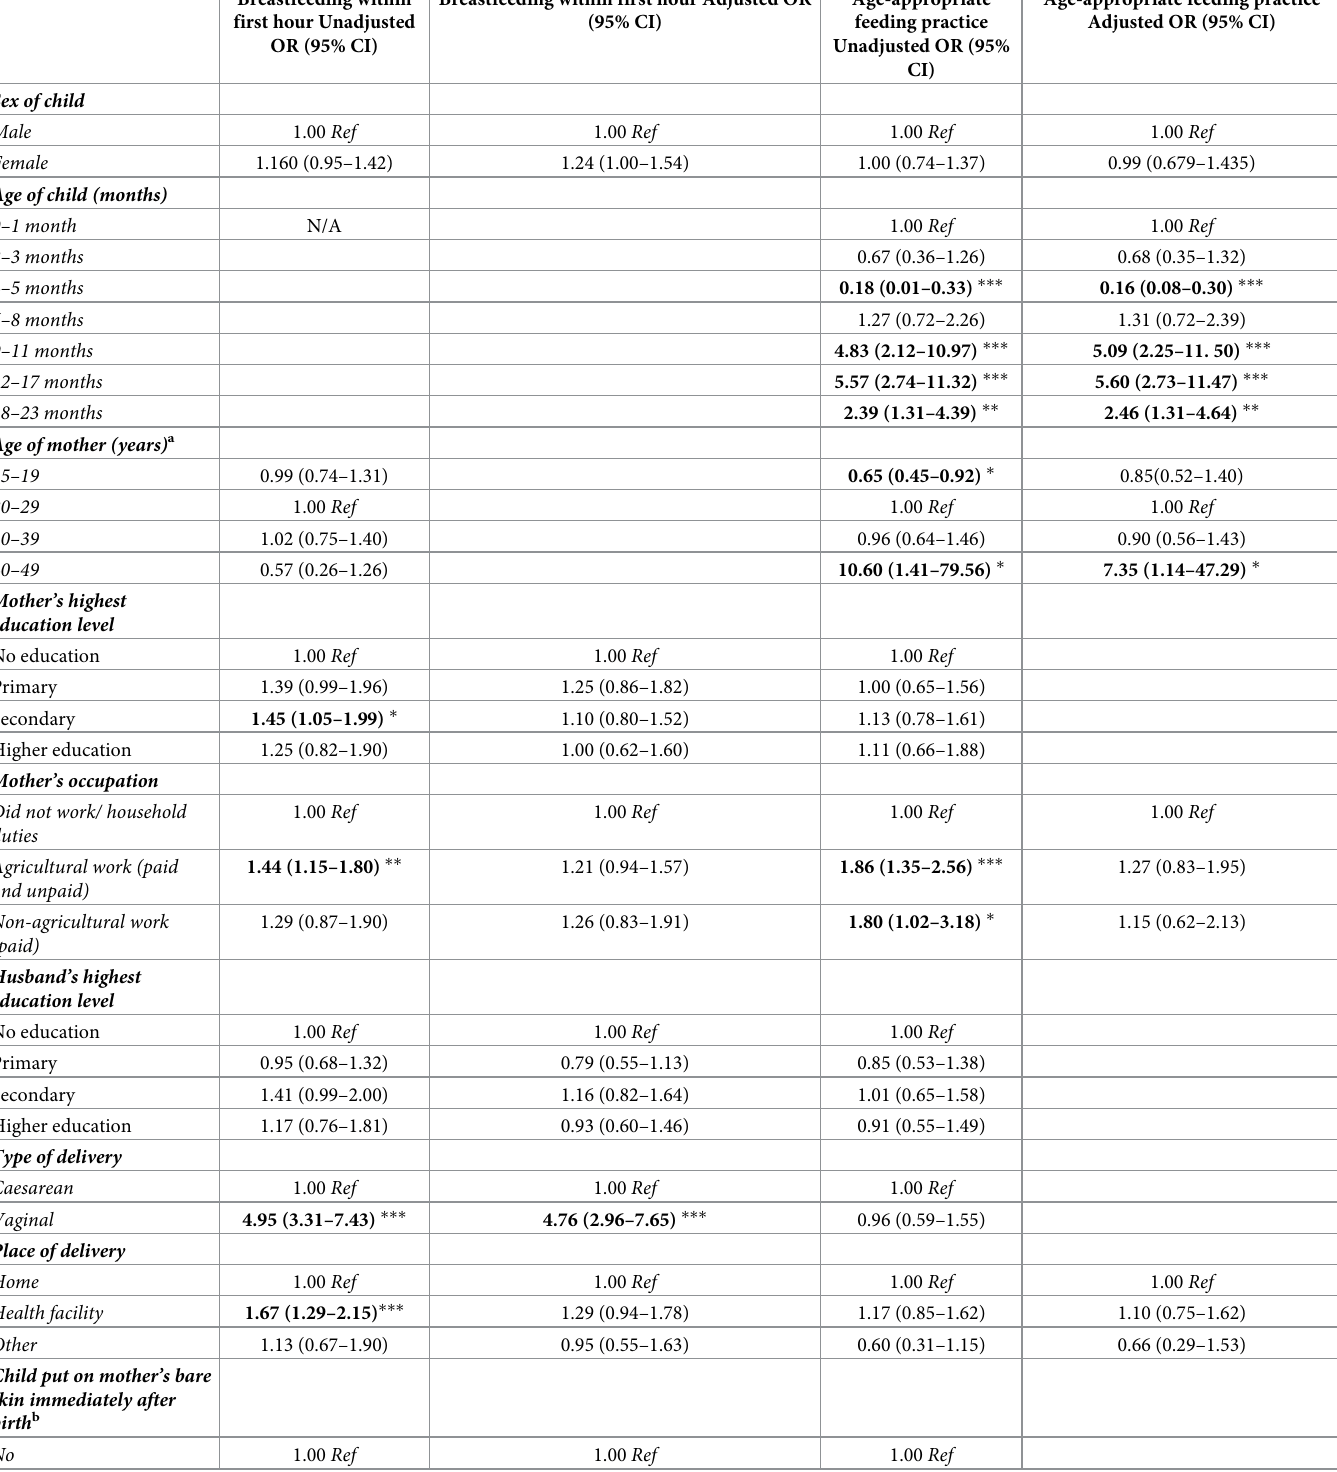
Table 2. Unadjusted and adjusted odds ratios for factors influencing breastfeeding within one hour post-delivery and age-appropriate infant and young child feed- ing (IYCF) practice (n =